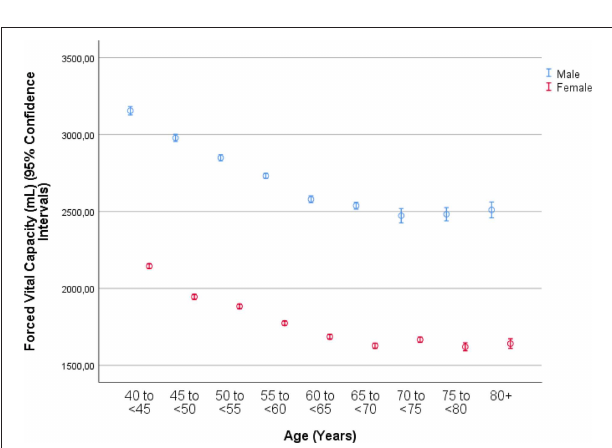
FIGURE 2 | Graph showing the distribution of the forced expiratory volume in 1s, stratified by age and gender, in the Ural Eye and Medical Study.